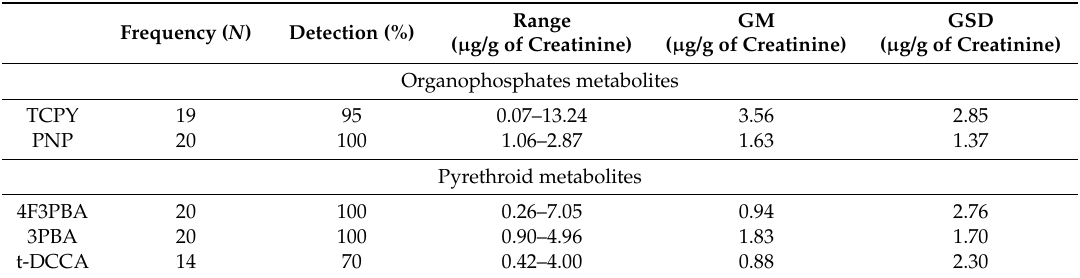
Table 4. The creatinine-adjusted urine metabolite concentrations ( N = 20).